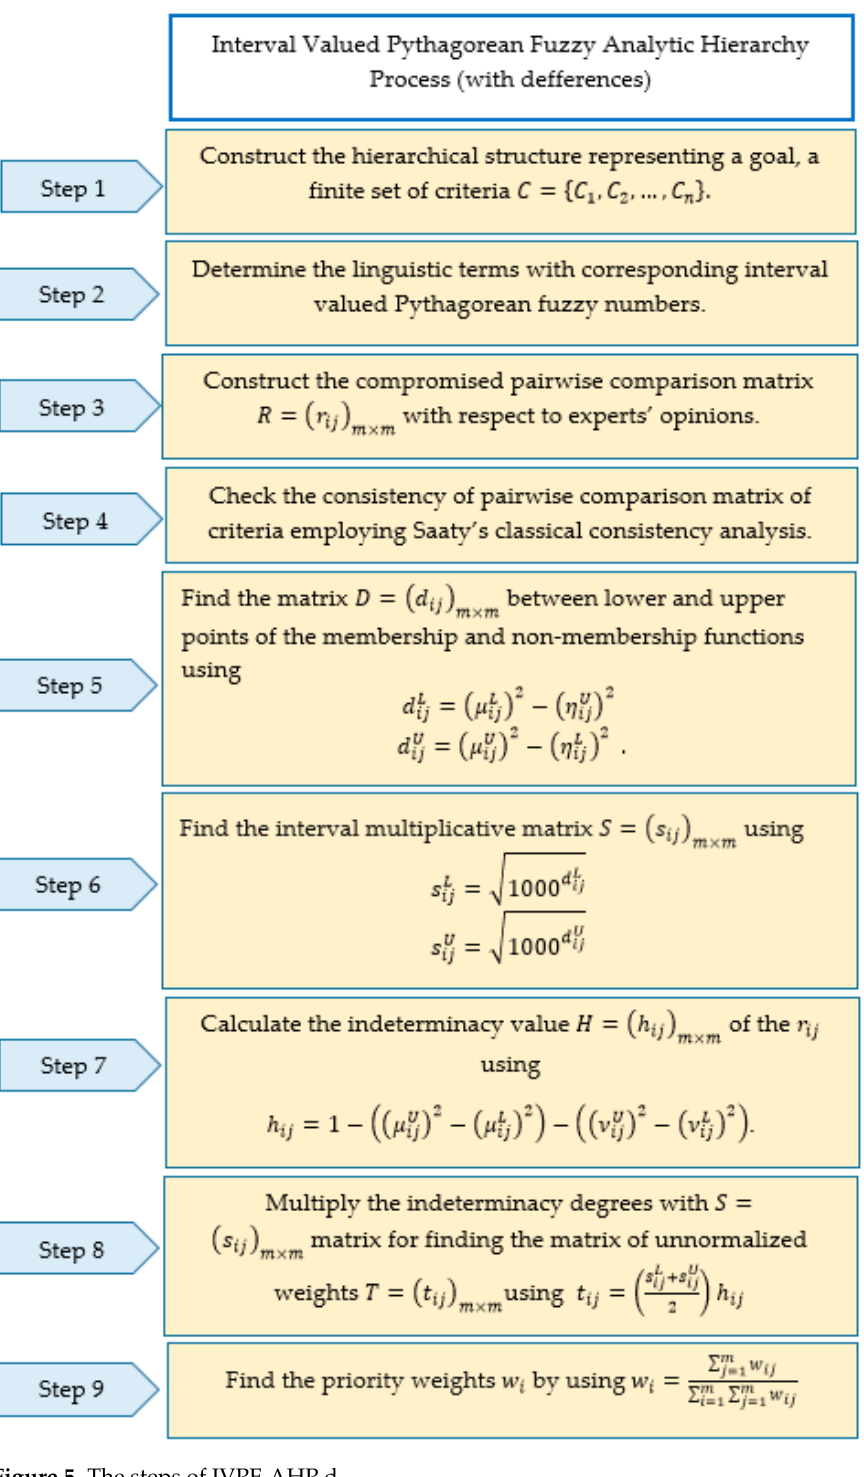
Figure 5. The steps of IVPF-AHP d.